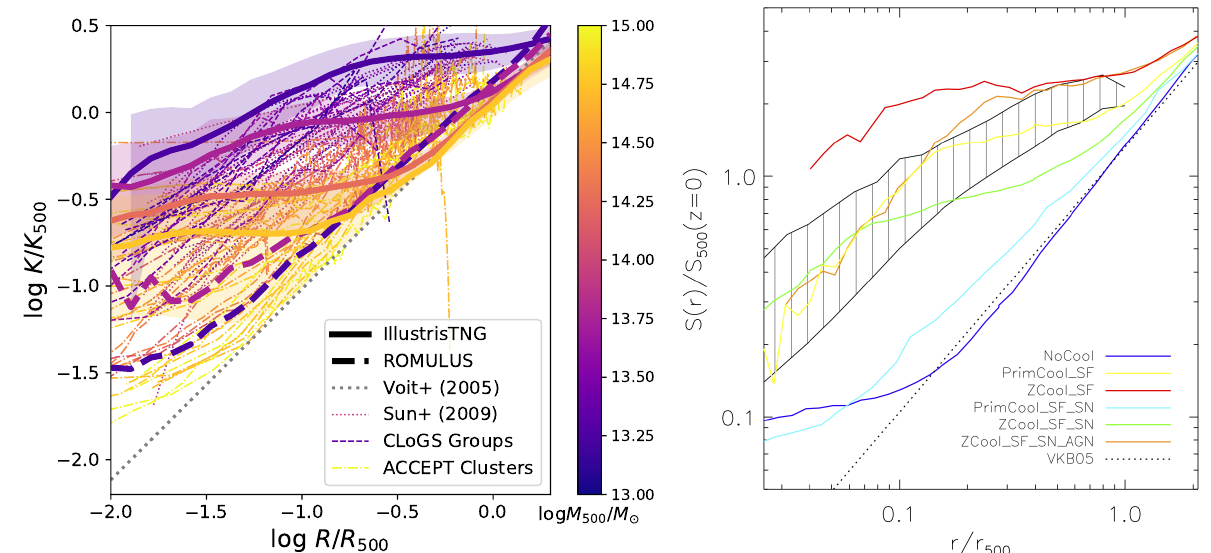
Figure 6. ( Left ) Normalized mass-weighted 3D entropy profiles at z 0 for groups and clusters with M 500 = 10 13 –10 15 M ∼ (cid:12) in TNG100 and TNG300 (combined, thick solid lines) and ROMULUS (thick dashed lines). We show median-stacked profiles of halos in 0.5 dex bins, with 264 (7), 110 (5), 91, and 15 halos per bin for TNG (ROMULUS) in order of increasing mass, color-coded by mass from low-mass groups (purple) to massive clusters (yellow). For TNG, we also indicate their 1 σ scatter with shaded bands. These predictions are compared to individual halos from three observed samples, all colored analogously by halo mass: low-mass CLoGS groups (dashed lines [8]), massive groups (dotted lines[2]), and a random 20% subset of the ACCEPT clusters (dash-dotted lines [9]). The gray dotted line indicates the K ∝ r 1.1 scaling found in non-radiative simulations [96]. In agreement with observations, TNG (but not ROMULUS) predicts higher normalized entropy at lower mass, but with higher-entropy cores than observed. In contrast, ROMULUS groups have steeper and lower entropy profiles that are more typical of observed massive clusters. ( Right ) Normalized mass-weighted 3D entropy profiles of M 500 = 10 13.25 –10 14.25 M groups predicted by OWLS simulations with different subgrid models [116], reproduced with (cid:12) permission from McCarthy et al. [158] (note that their symbol for astrophysical entropy is S , rather than K ). Simulations include a run without any cooling or feedback (blue); without feedback but with star formation and cooling without (yellow) or with (red) the contribution from metal lines; with the addition of SNe feedback (cyan and green, respectively); and with AGN feedback added in addition to metal-line cooling, star formation, and SNe feedback (brown). The black-hatched band indicates the 1 σ scatter of the Sun et al. [2] observations, the black dotted line a r 1.1 power law. While AGN feedback has a clear effect on the IGrM, the entropy profiles are also sensitively affected by cooling, star formation, and SNe